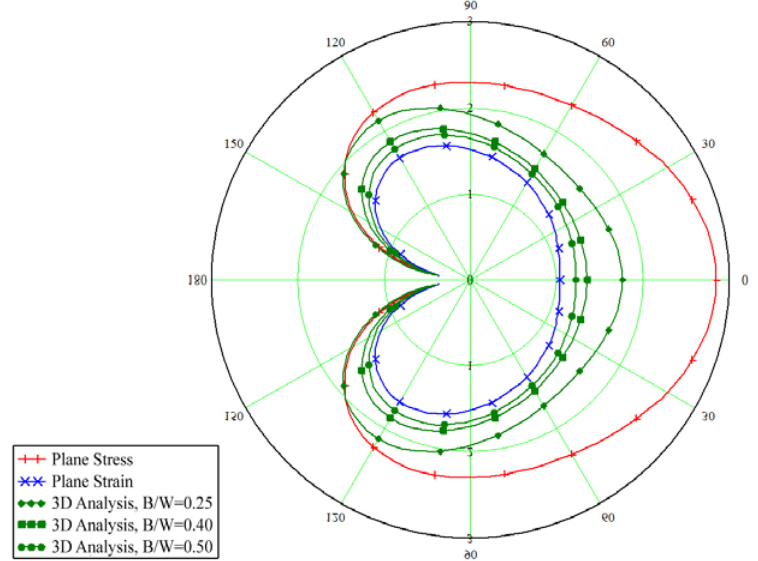
Figure 2: The angular distribution of crack tip plastic zone sizes for the middle plane in the CT specimen. The stress intensity factor K I is assumed to be constant independently on specimen thickness and equal to 66 MPa  m 1/2 . Corresponding values of the T -stress components are presented in Tab. 1. Sizes of the plastic zone around the crack tip with provision for the spatial stress state (3D Analysis) are surrounded by sizes of the zones corresponding to two